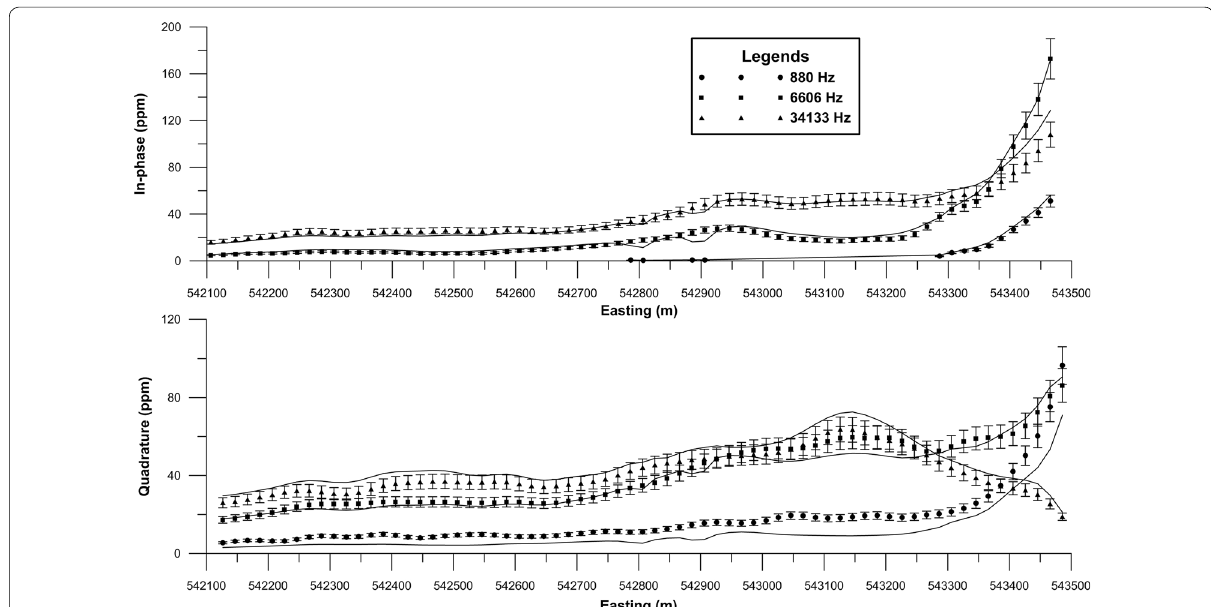
Fig. 5 Fitting between observed HEM data (symbols with error bars) and computed data (solid lines) from quasi‑3D inversion along ERT line